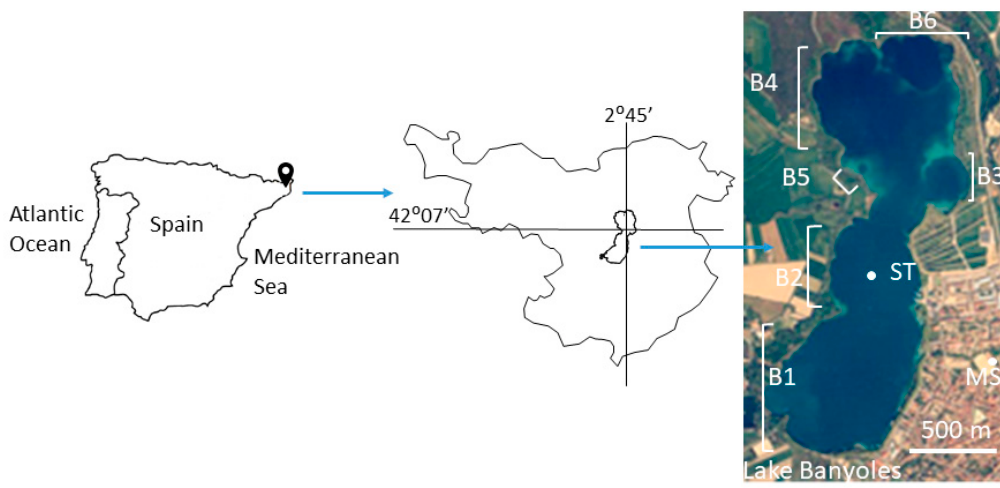
Figure 1. Location of Lake Banyoles and photograph of Lake Banyoles. The photograph of Lake Banyoles was kindly provided by the Institut Cartogràfic de Catalunya. B1–B6 represent the location of the different basins of Lake Banyoles. ST represents the sampling station where temperature and turbidity were measured. MS represents the location of the meteorological station in Lake Banyoles.